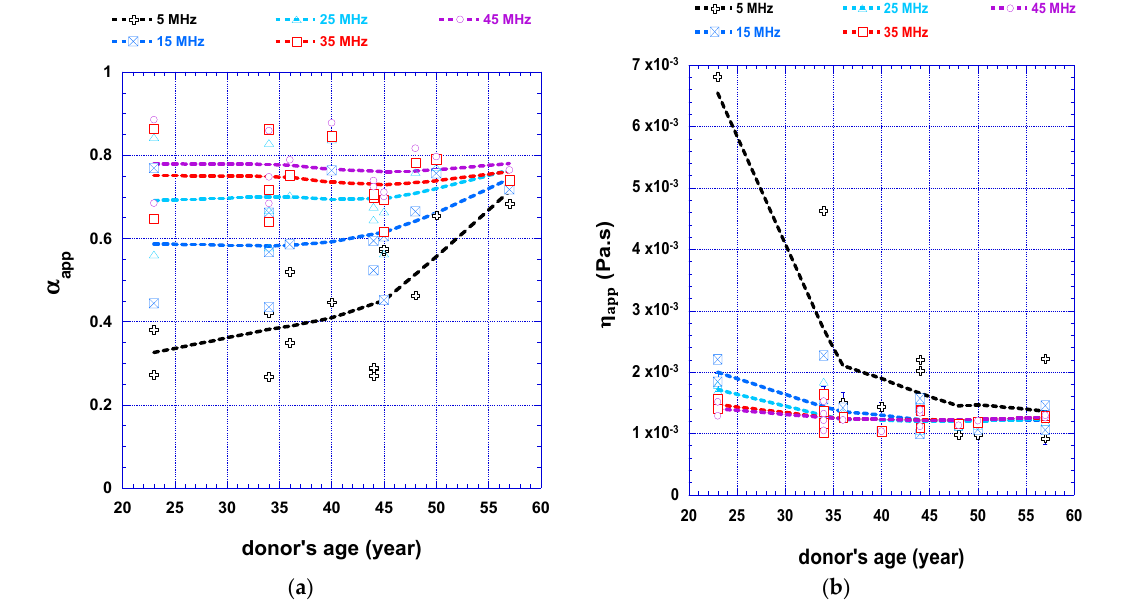
Figure 6. Skin aging related changes on a mesoscopic scale during living of skin explants (from time frame 1 to 3 day): ( a ) changes of apparent structural parameter; ( b ) changes of apparent viscosity. According to Figure 6a, for upper harmonics, the value of the structural parameter is around 0.7 to 0.75. This value agrees with Zimm’s theory and with the ultrasonic studies that were carried out on gels [39,91]. Thus, the dominant component of the dermis, seen on the mesoscopic scale, seems to be the ground substance. Consequently, the very low values for skin samples under 40 years old at 5 MHz ( 𝛼 (cid:3028)(cid:3043)(cid:3043) from 0.3 to 0.5) are consistent with a well-structured elastin and collagen fibres network providing skin strength and elasticity. In addition, 𝛼 (cid:3028)(cid:3043)(cid:3043) increases as a function of the donor’s age. The dermis fibres network degradation and the DEJ flattening that both arise with cutaneous ageing can explain this observation.